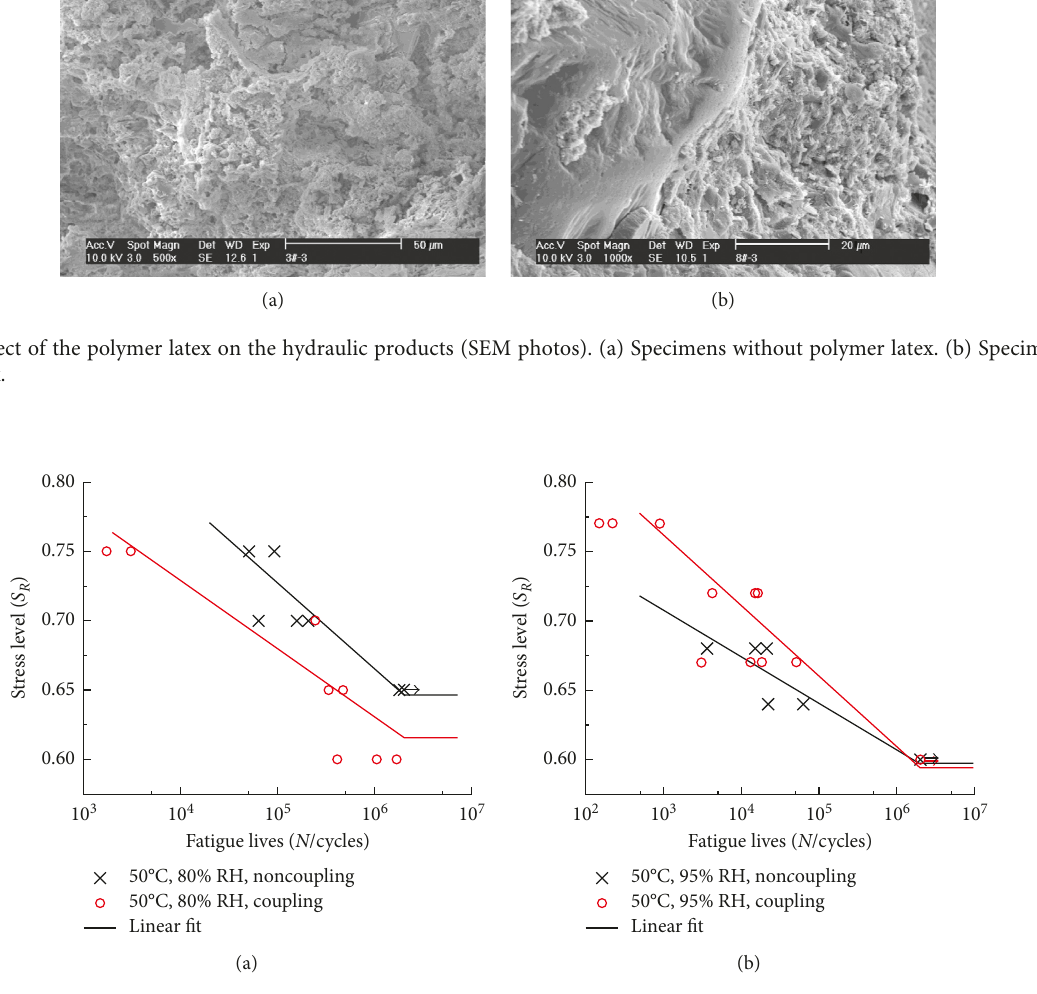
∼ N curves. (a) 50 ° C and 80% RH. (b) 50 ° C and 95% R